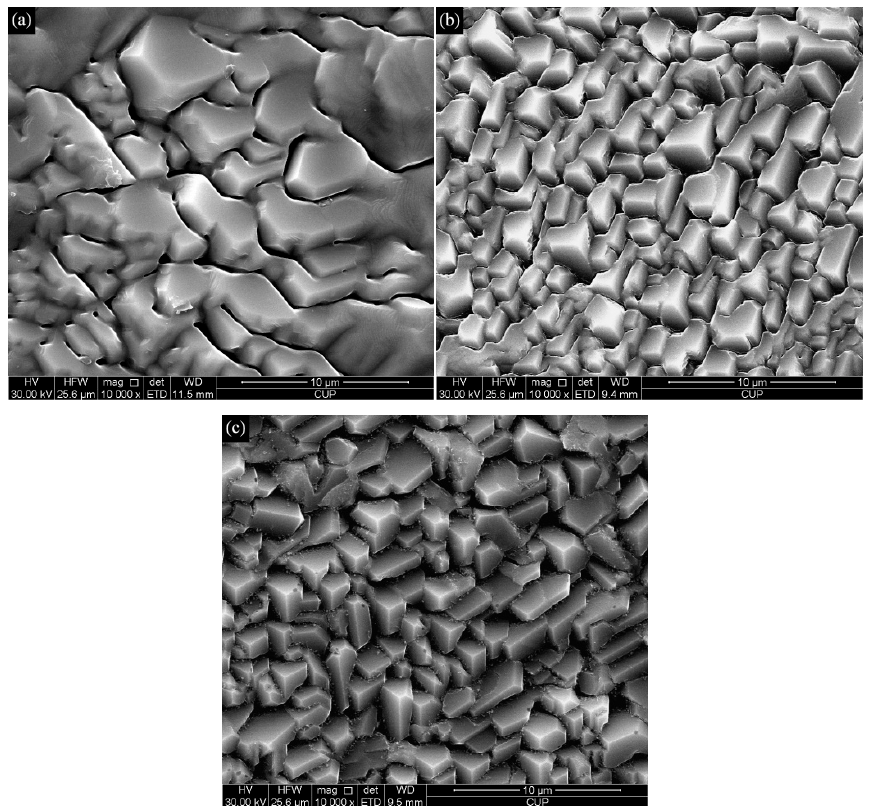
Figure 1. The surface morphologies of the as-deposited coatings: ( a ) NiAl–Hf, ( b ) NiAl–Zr, ( c ) NiAl– Hf–Zr.